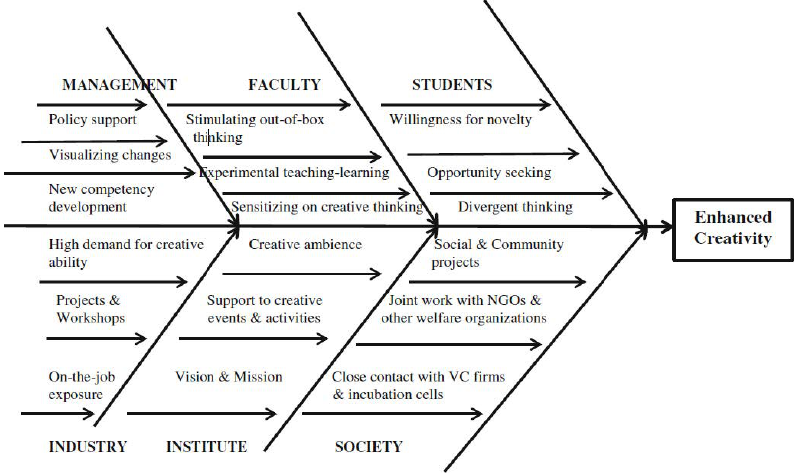
Fig. 2 Scheme process of space model design in art teaching